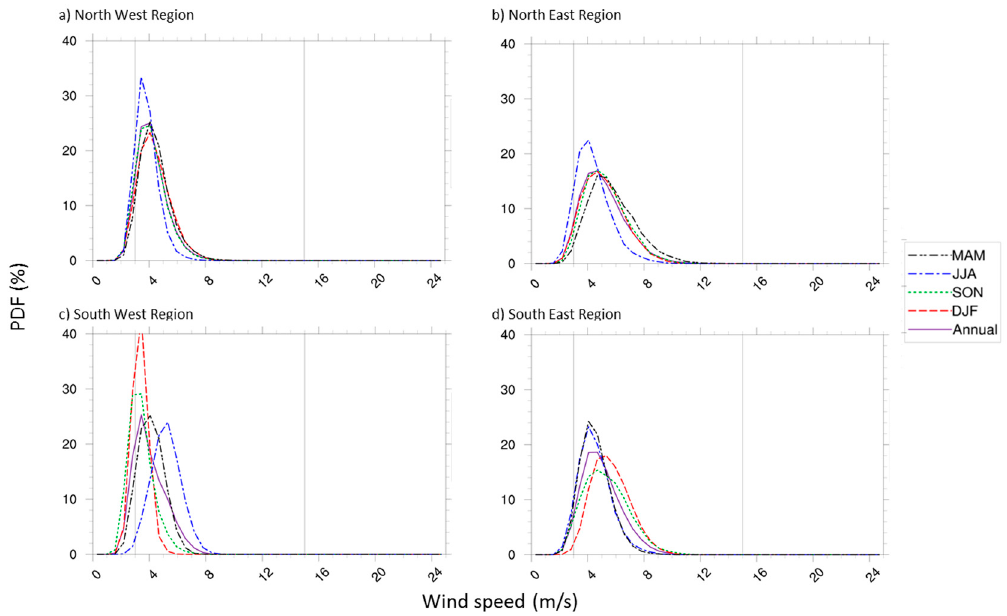
Figure 7. Probability distribution function (PDFs) of wind speed for the four seasons over ( a ) North West region, ( b ) North East region, ( c ) South West region, and ( d ) South East region.